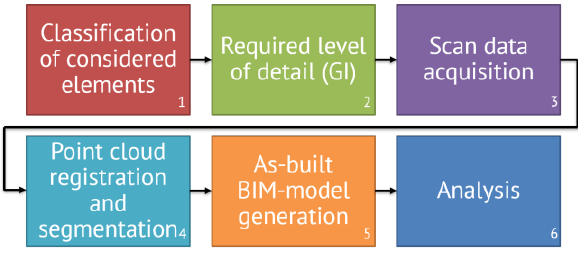
Figure 1. Six steps of the proposed methodology